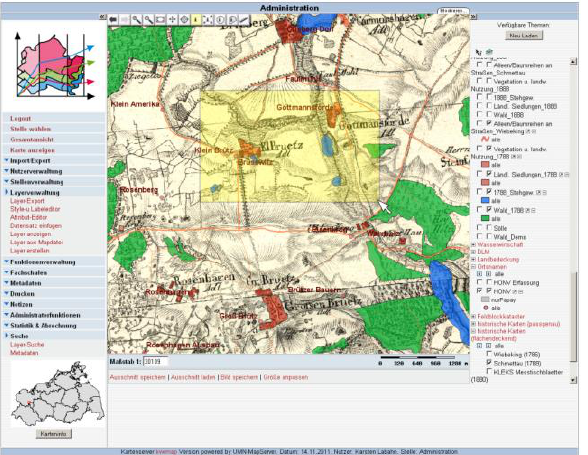
Figure 3. Search query for documents in kvwmap.